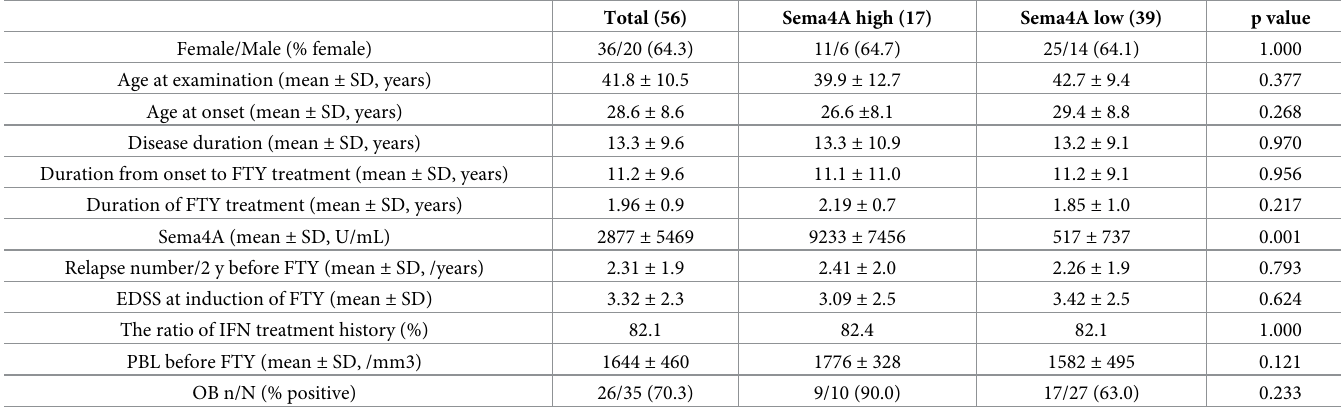
Table 1. Clinical characteristics of subjects in fingolimod